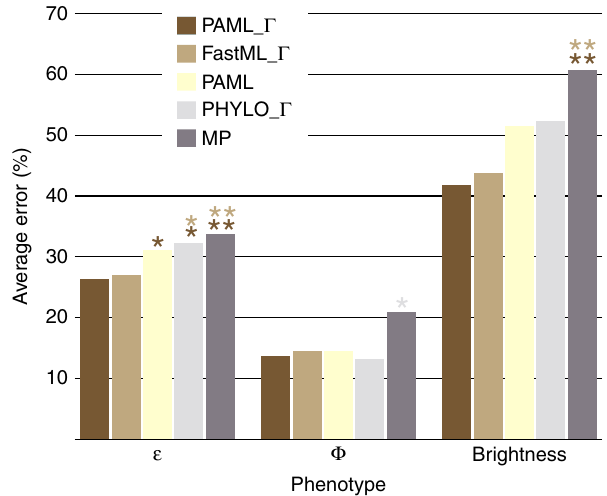
Figure 3 | Average phenotypic error across all nodes for the five ASR procedures. Extinction coefficient ( e ), quantum yield ( F ), and brightness (product of e and F ) were determined for all incorrectly inferred ancestral FP proteins and compared to the properties of the true ancestral protein at each node and reported as a function of percent error. Dark brown bars are PAML with a gamma distribution, light brown bars are FastML with a gamma distribution, yellow bars are PAML, light grey bars are PhyloBayes with a gamma distribution, and dark grey bars are maximum parsimony. Single and double asterisks represent confidence at 95% and 99% levels, respectively, and are coloured according to the respective procedure that has significantly less